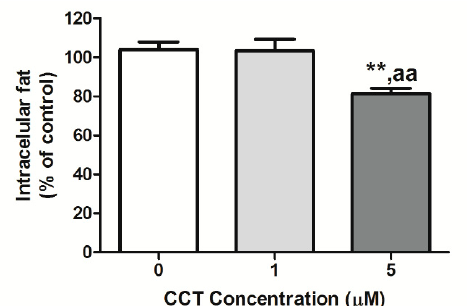
Figure 2. E ff ect of CCT on lipid accumulation. The maximum intracellular fat detected in control di ff erentiated cells (CCT 0 µ M) was set to 100%; the relative intracellular fat levels of CCT-di ff erentiated cells are shown. Values were obtained at the FD time-point. Data from at least 10 replicates in each condition from three independent experiments are expressed as the mean ± SD. ** indicates a significant di ff erence compared with the control di ff erentiated cells ( p < 0.01); aa indicates a significant di ff erence compared with 1 µ M CCT ( p < 0.01).